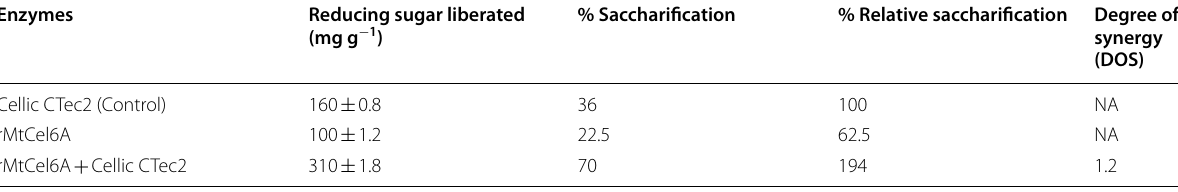
Table 4 Saccharification profile of rMtCel6A in combination with Cellic